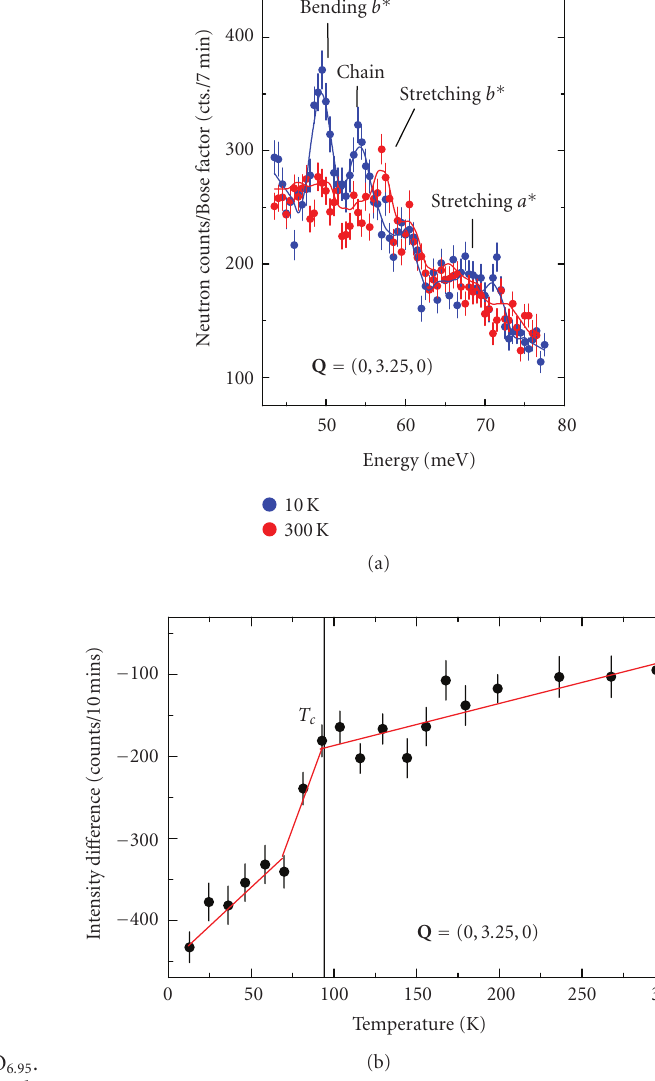
Figure 24: Data of [74] for the (cid:2) 1 symmetry. (a) Phonon spectra at 300 K and 10 K. The main di ff erence with [73] and Figure 22 is a bigger energy range here: 42–75 meV in [74] versus 51–72 meV in [73]. (b) The di ff erence between the intensity at 57meV and the average of intensities at 53 meV and 49 meV at Q = (0, 3.25, 0). Temperature dependence above T c not seen in Figure 22